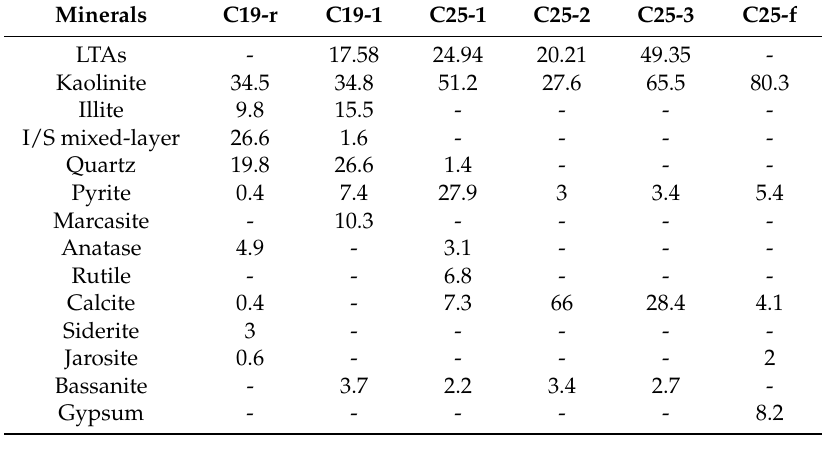
Table 3. LTA yields of coal samples and mineral compositions (%) of coal LTAs, partings, roofs, and floors determined by XRD and Siroquant.